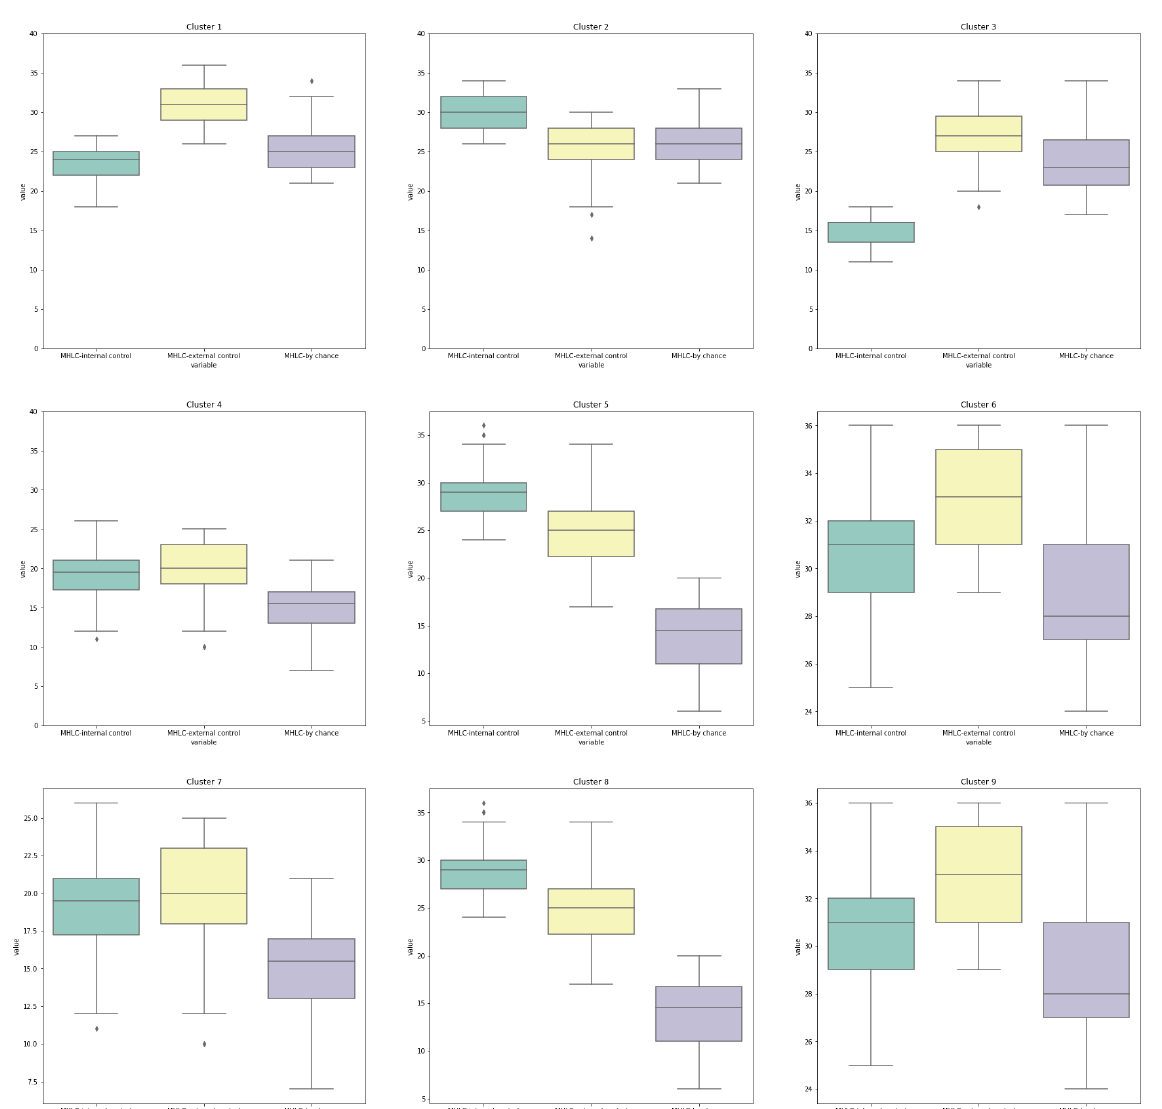
Figure 6. Distribution of 3 analyzed characteristics with 9 clusters generated by K-Means algorithm.